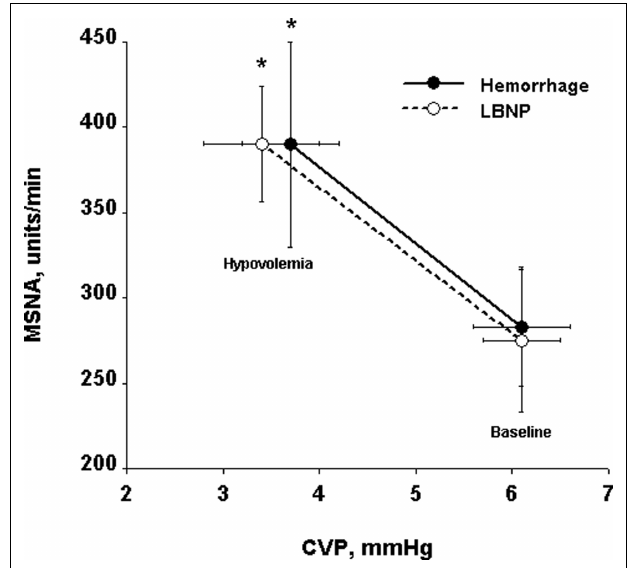
FIGURE 1 | Comparison of relationships between central venous pressure (CVP) and muscle sympathetic nerve activity (MSNA) during − 10mmHg LBNP and 450ml hemorrhage in nine human subjects. Circles and lines represent mean ± SE values. * P < 0.05 compared with baseline. From Cooke et al. (2004) using data modified from Rea et al.